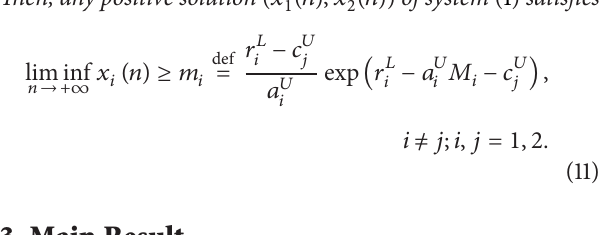
Figure 3: Uniformly asymptotic stability. (a), (c) Time-series 𝑥 ∗ 1 (𝑛) and 𝑥 ∗ 2 (𝑛) with initial values 𝑥 ∗ 1 (0) = 1.19 , 𝑥 ∗ 2 (0) = 1.18 and 𝑥 1 (𝑛) and (𝑛) with initial values 𝑥 𝑥 2 above initial values for 𝑛 ∈ [700, 800] ,